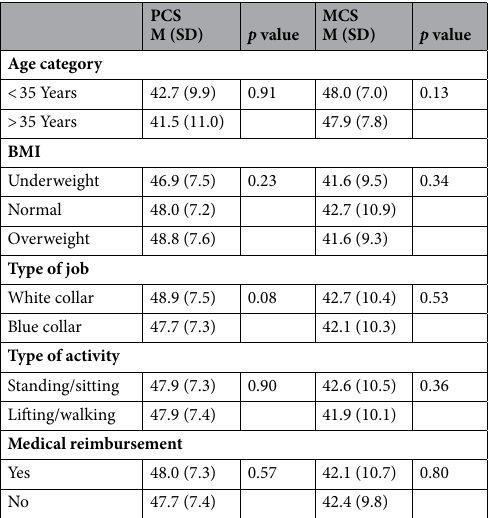
Table 5. Scores of various domains in various subgroups (N = 805). BMI: Body Mass Index; PCS: Physical Component Score; MCS: Mental Component Score; M: Mean; SD: Standard Deviation.